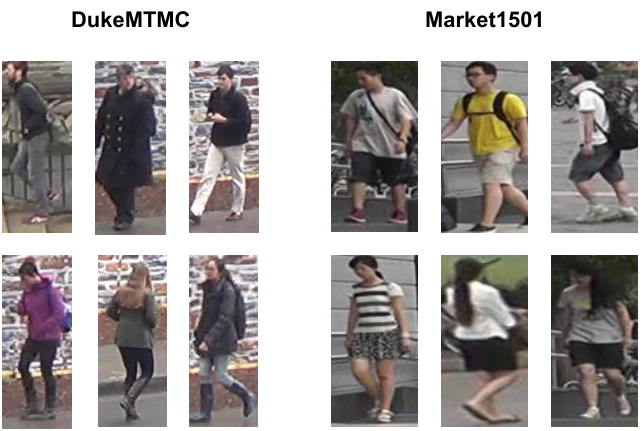
Figure 1. Compare different characteristics between two